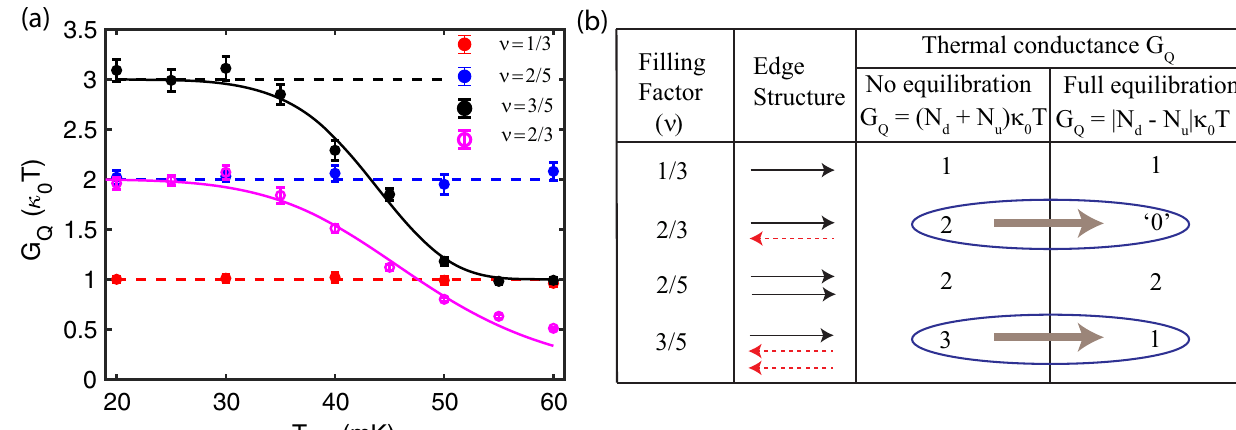
Fig. 4 | Crossover from nonequilibrated to equilibrated heat transport. a Thermal conductance G Q , as extracted from the slope of the linear fi t in Fig. 3, plottedasafunctionofthebathtemperaturefor ν =1/3(red),2/5(blue),3/5(black), and 2/3 (magenta). The horizontal dashed lines correspond to quantized values of G Q .Thesolidcurves(blackandmagenta)aretheoretical fi tsofthedatathatserveto extractouttemperaturescalingexponents(seeMethods).Errorbarscorrespondto